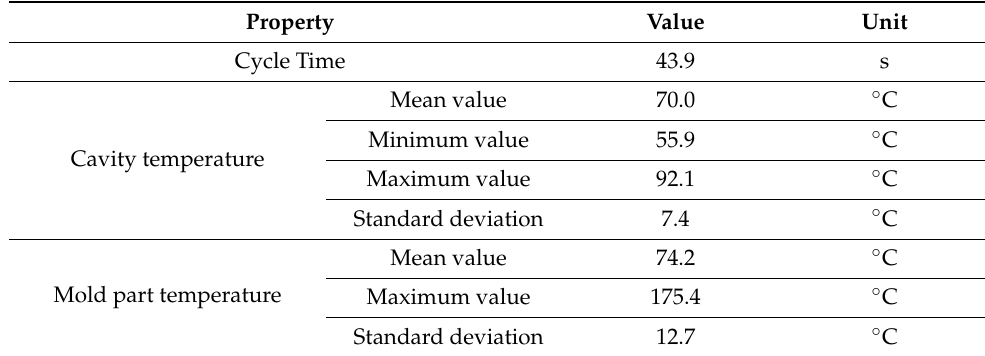
Table 5. Simulation results of the initial configuration.